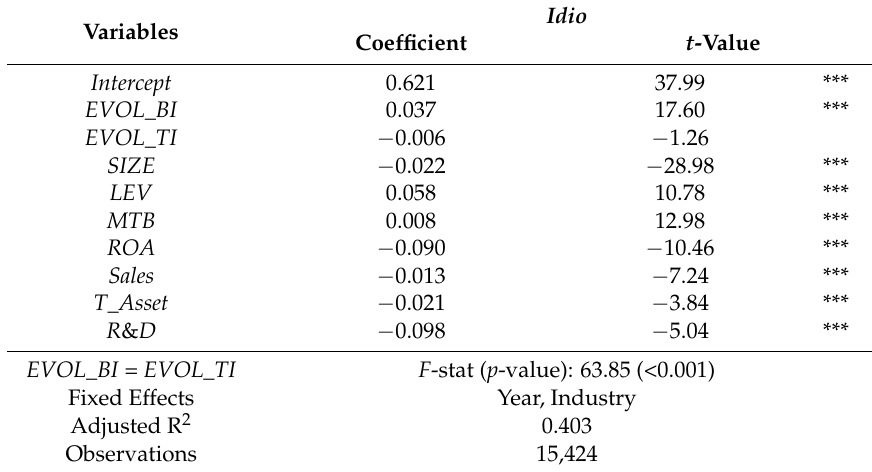
Panel B: The Collective Test for the Book Income and Taxable Income